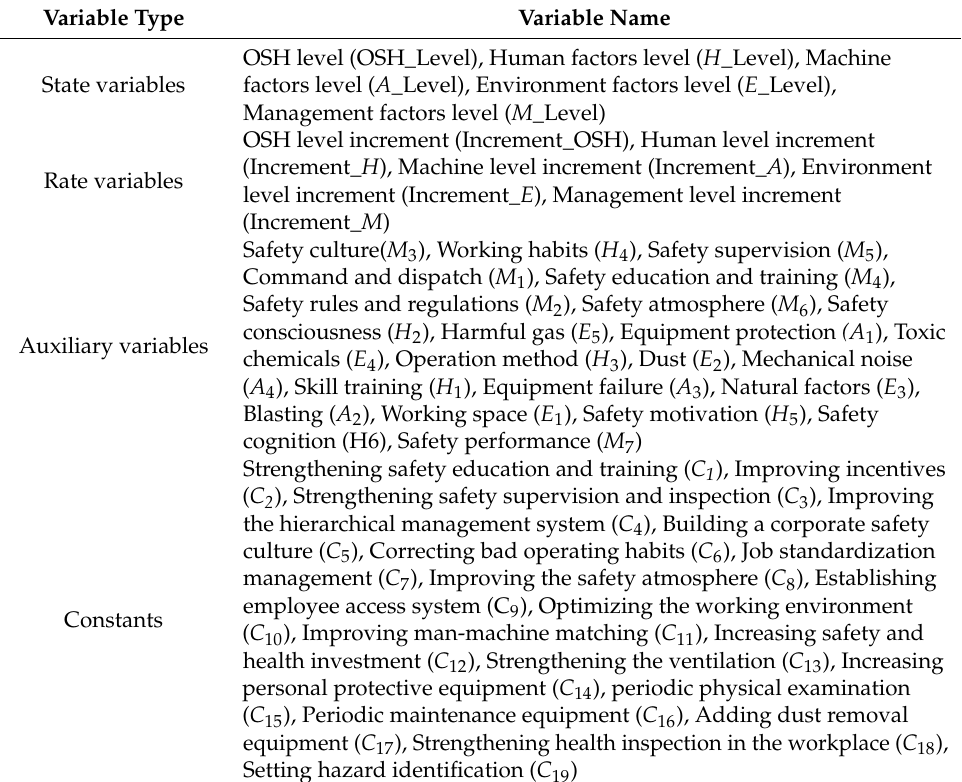
Table 4. System Dynamics (SD) simulation variable